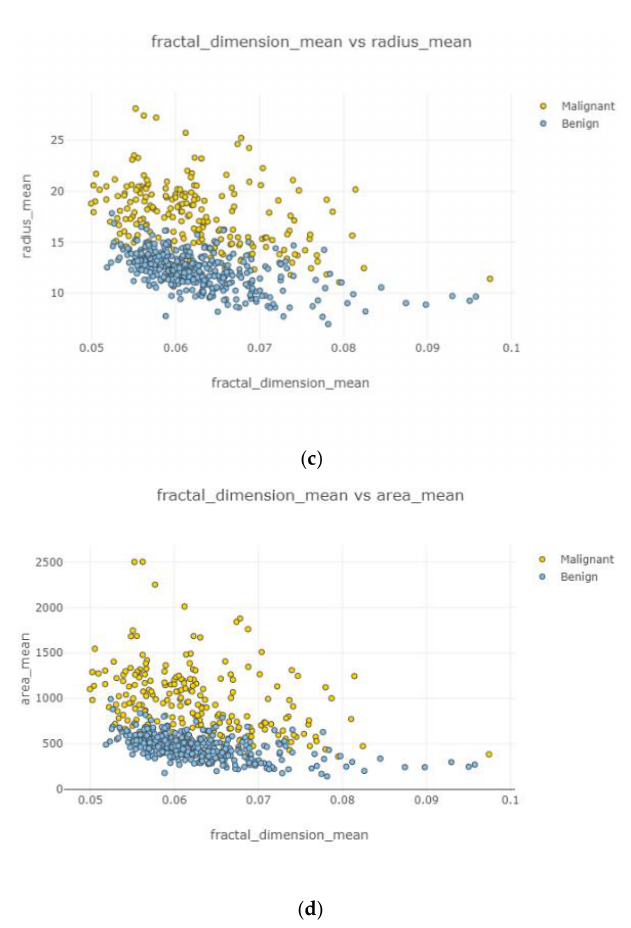
Figure 12. Negatively correlated scatter plots 1–4.